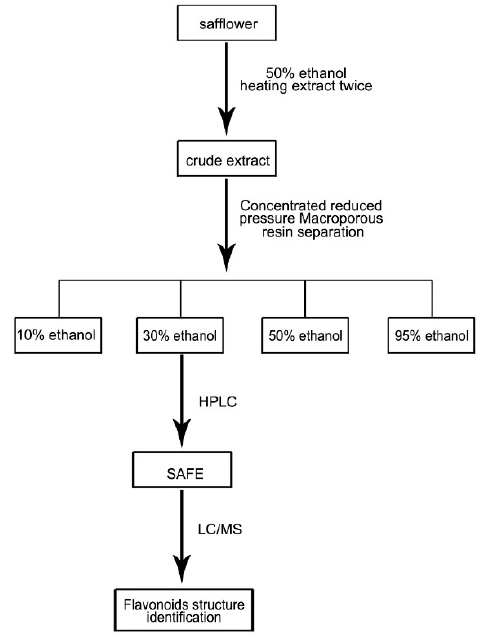
Figure 8. Extraction of SAFE route map.